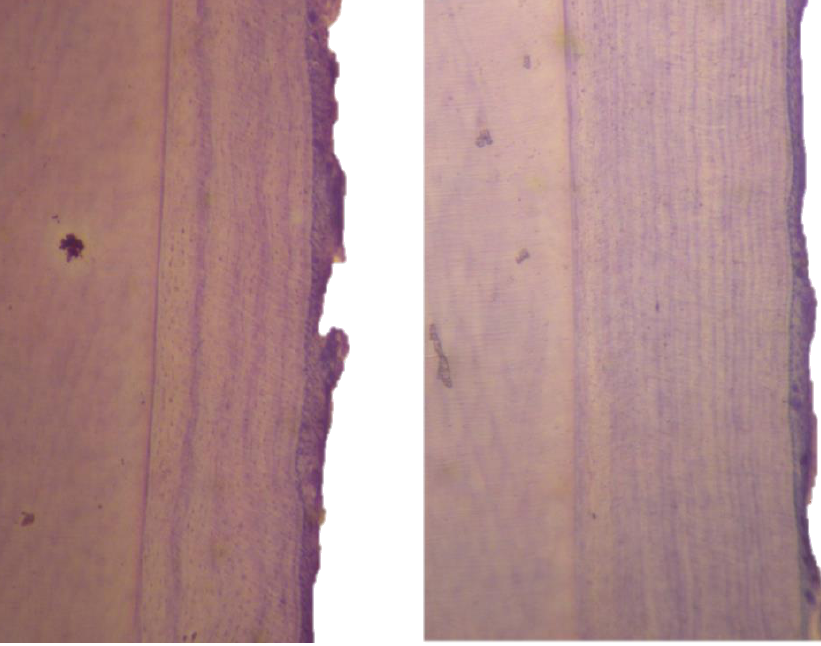
Fig. 7. Polar bear ( Ursus maritimus ) cementum in animals of differing ages (5 GLGs, left and 17 GLGs, right), sections stained with toluidine blue. For sections requiring longer immersion (many minutes) in stain ( e.g.